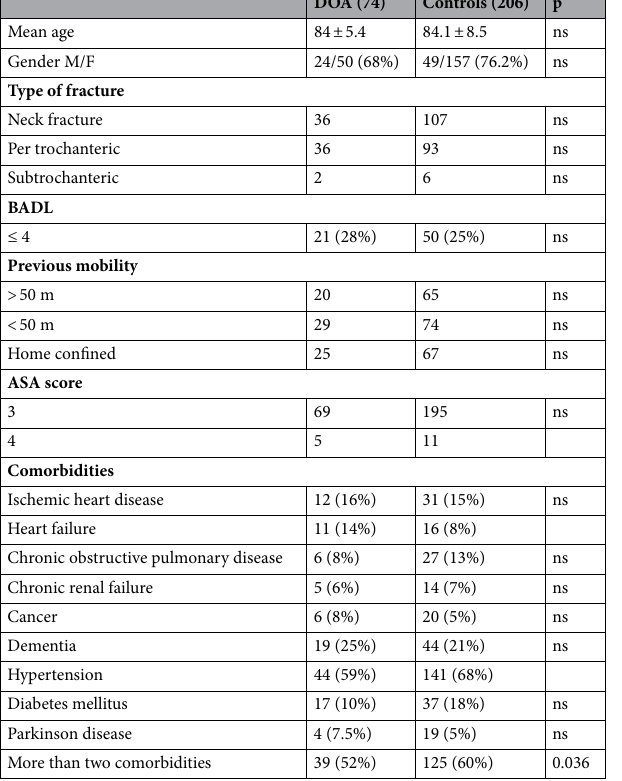
Table 2. Characteristics of DOACs patients and controls.